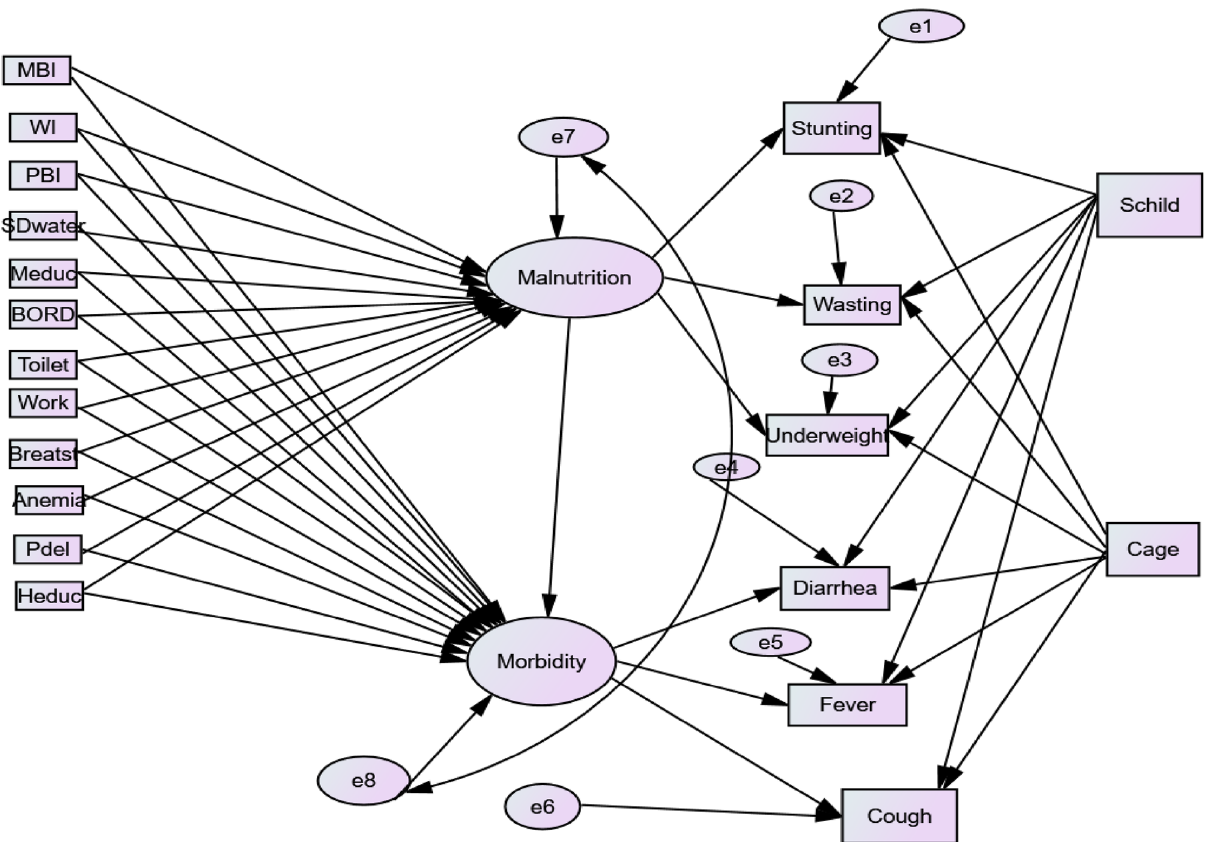
Figure 1. Proposed theoretical Generalized SEM path diagram of child malnutrition and morbidity in